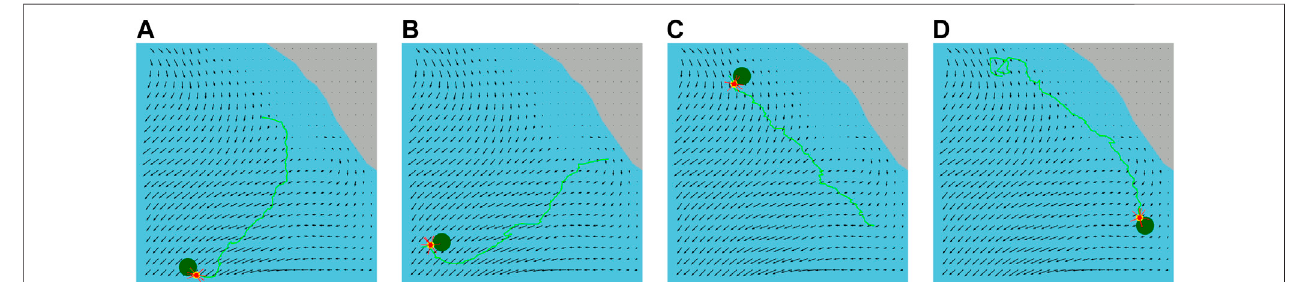
FIGURE 6 | Executed trajectories (green lines) of the vehicle (red circles) from its varying initial locations to different goal locations (green circles) applying the synthesized feedback plan on the water surface layer.